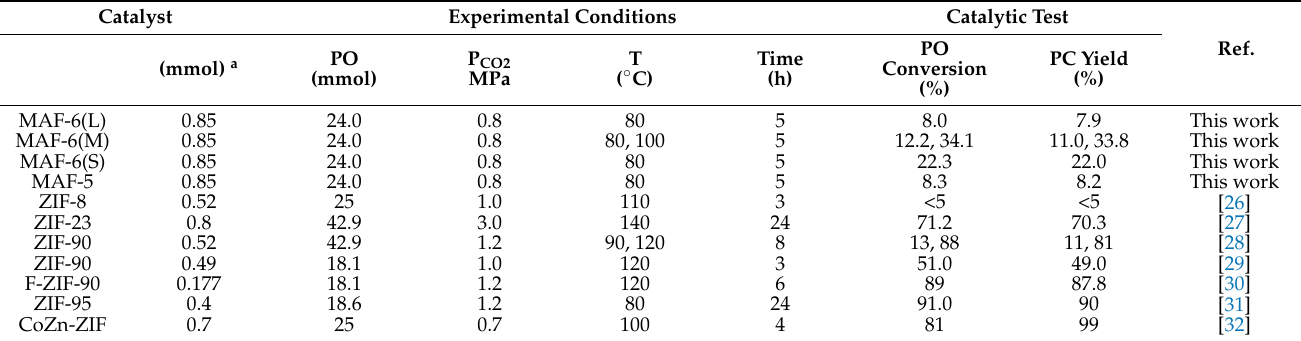
Table 1. Cycloaddition of CO 2 to propylene oxide in the presence of ZIFs without co-catalyst.